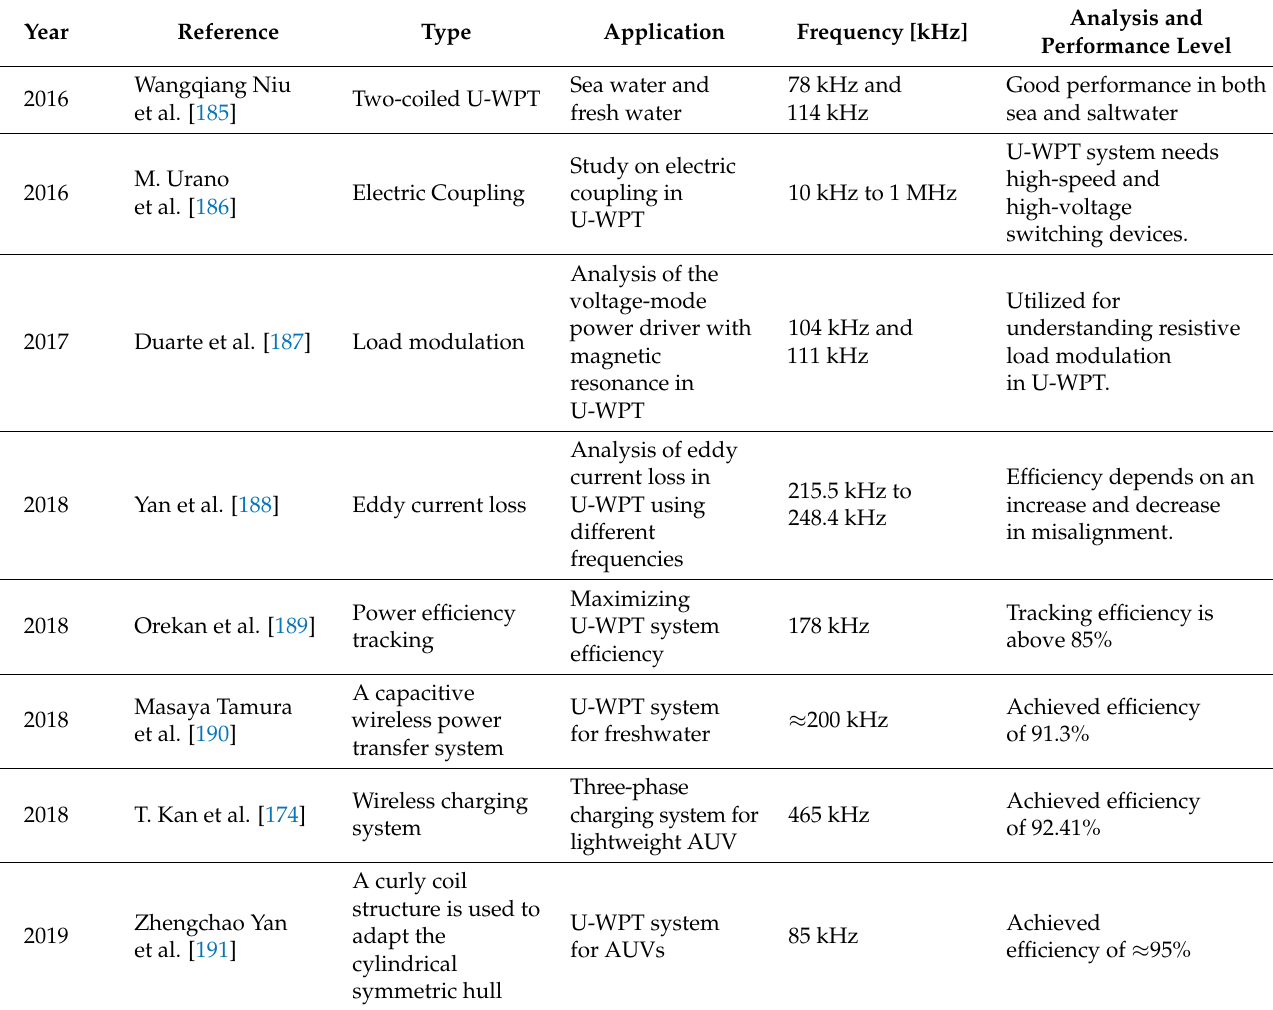
Table 3. Analysis on recent wireless power transfer techniques of UIoT networks since